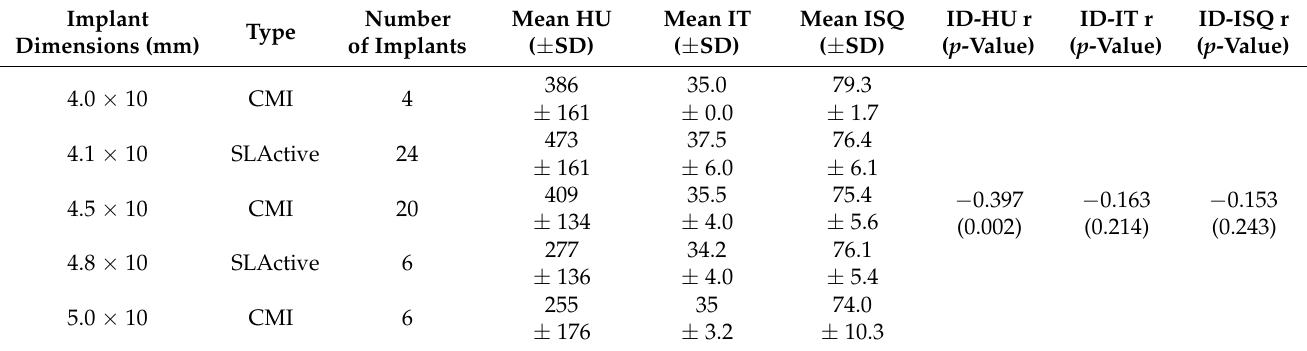
Table 2. Mean Hounsfield units, maximum insertion torque, and implant stability quotient values and corresponding correlations with implant